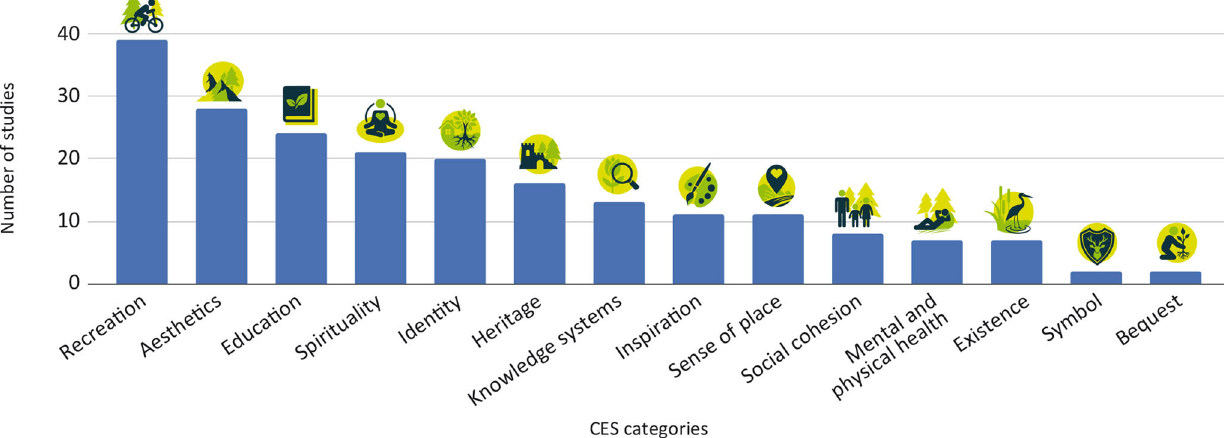
Fig. 6 CES categories addressed in the studies. Categories are based on MA, TEEB, CICES, and NCP frameworks but were elaborated into our own CES classi fi